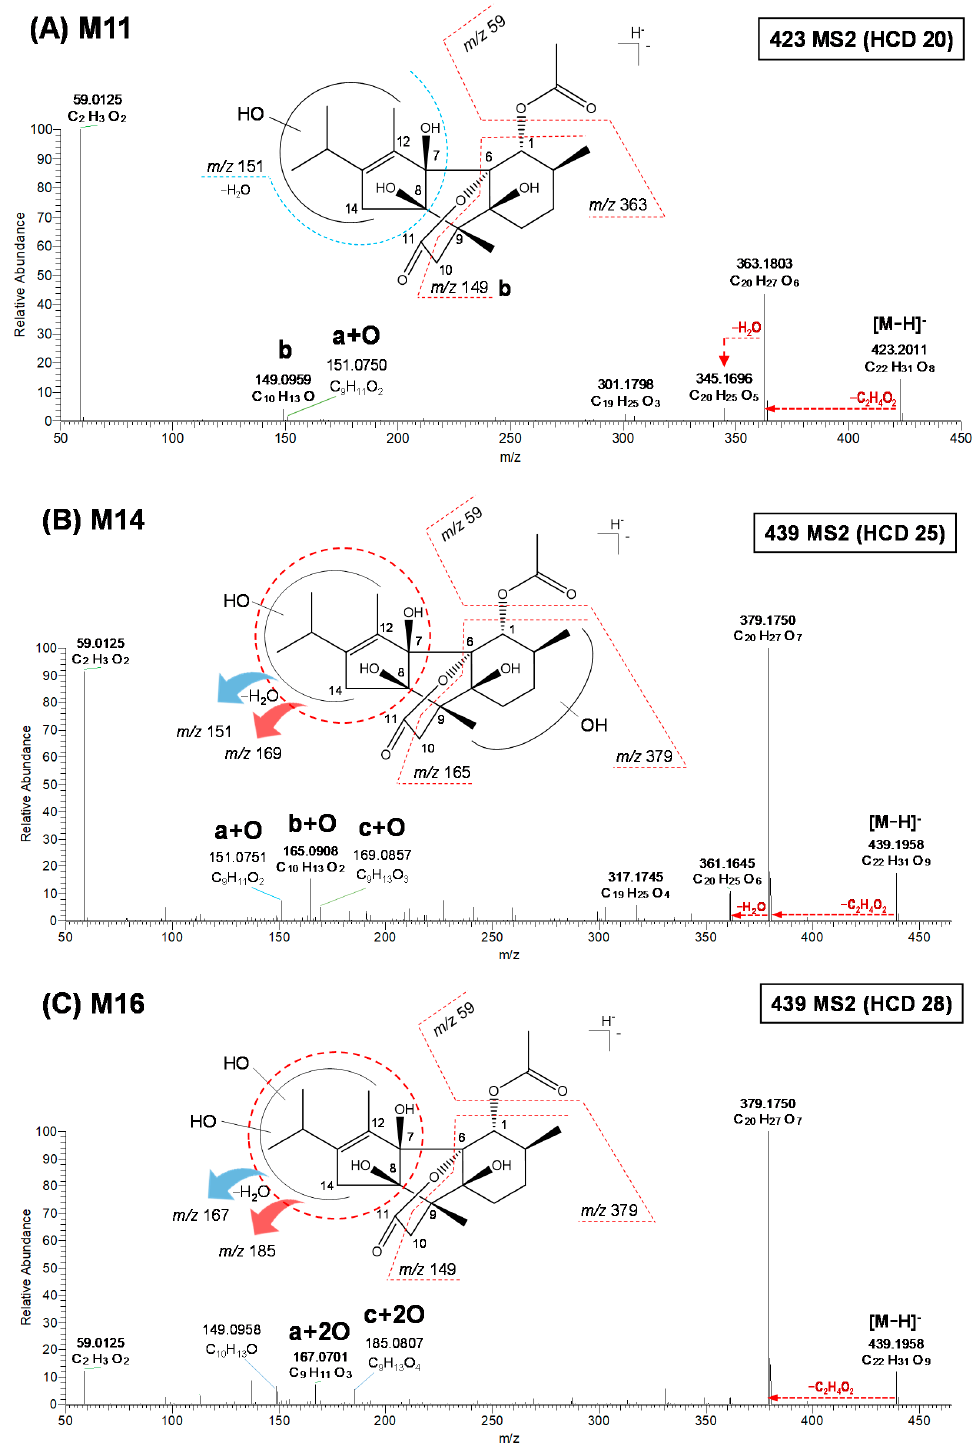
Figure 4. MS/MS spectra of deprotonated M11 ( A ), M14 ( B ), and M16 ( C ) obtained using a high- resolution quadrupole-orbitrap mass spectrometer. HCD, higher-energy C-trap dissociation.